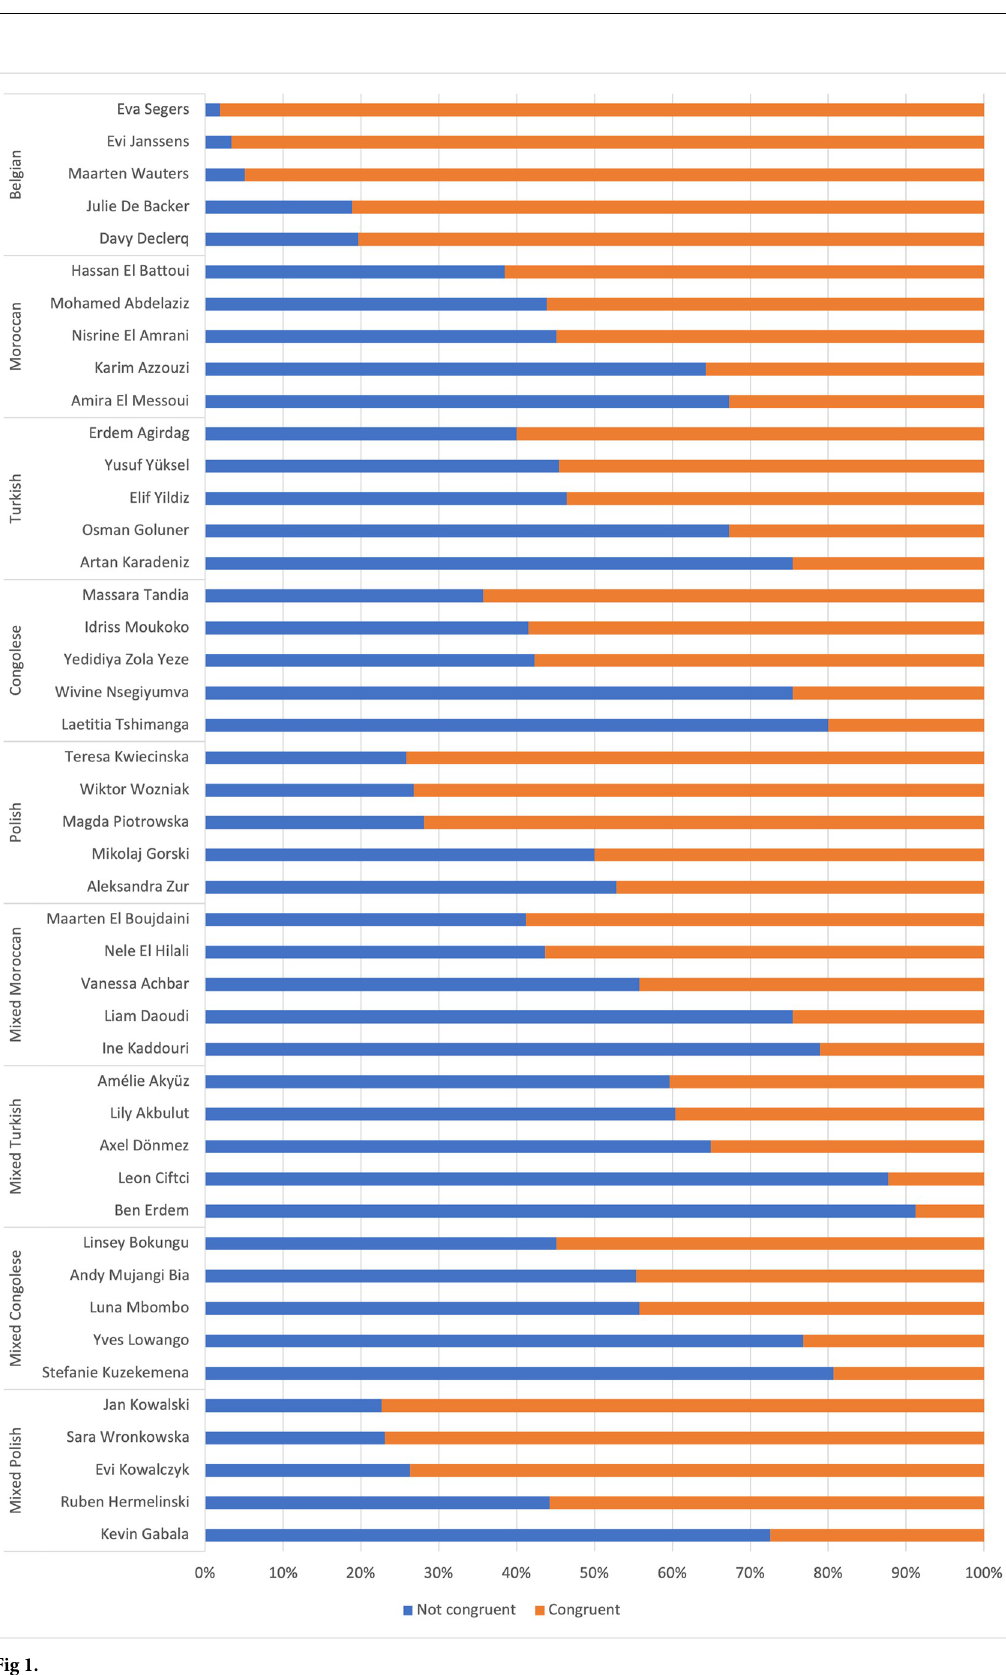
Fig 1. https://doi.org/10.1371/journal.pone.0270990.g001 PLOS ONE | https://doi.org/10.1371/journal.pone.0270990 August 2,